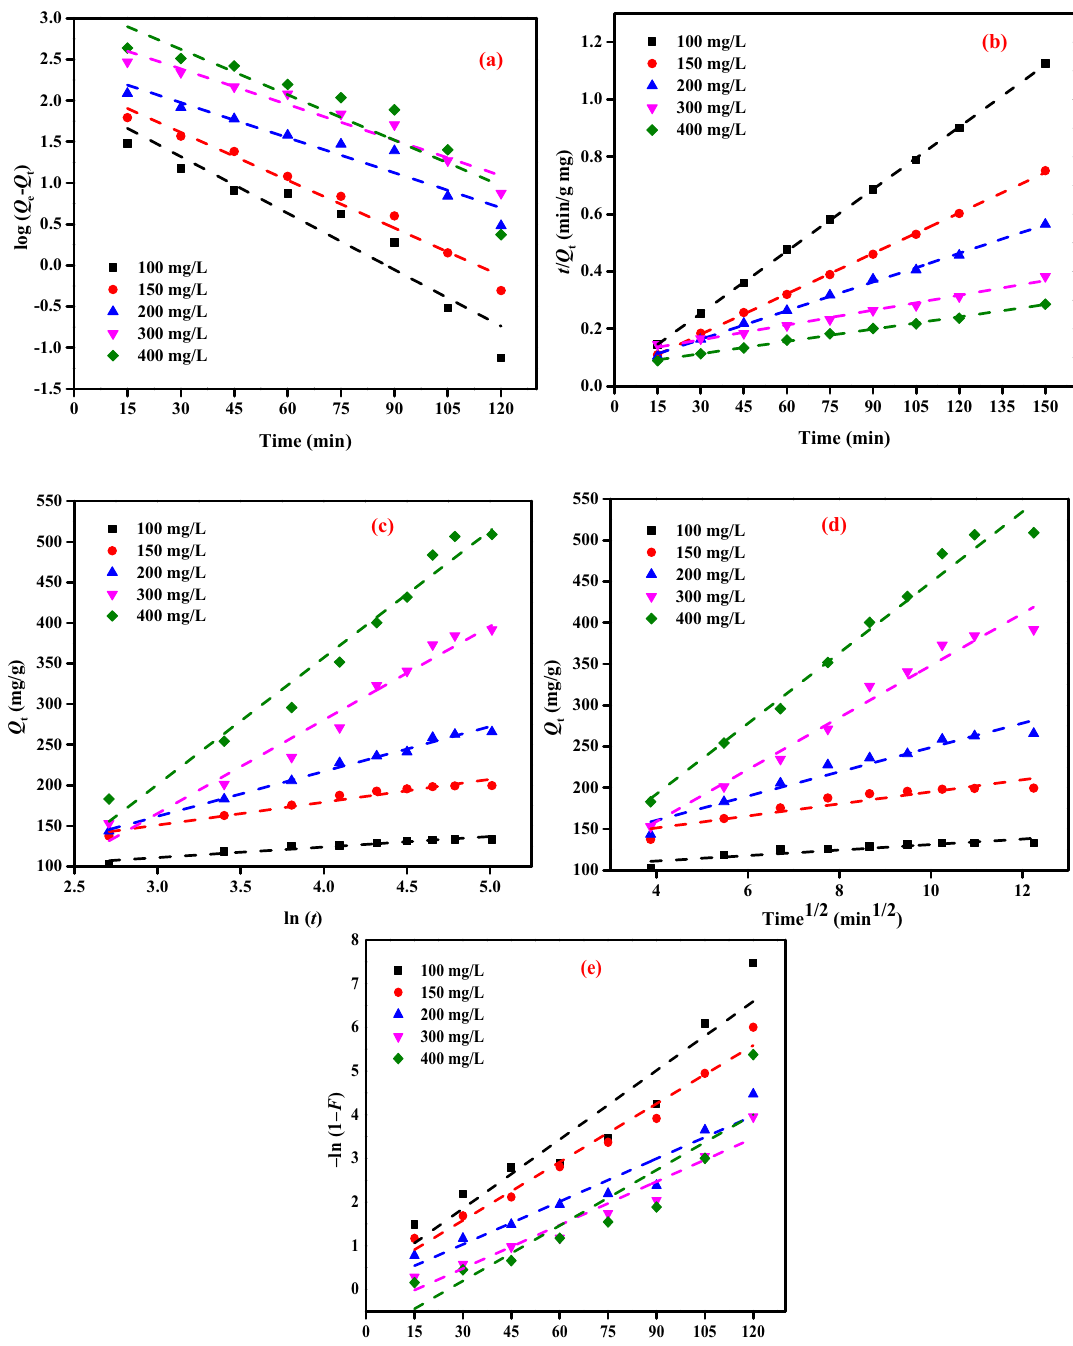
Figure 11. ( a ) PFOM, ( b ) PSOM, ( c ) EM, ( d ) IPDM, ( e ) FDM of AY11 dye removal by PPAC adsorbent (beginning concentration (100–400 mg/L), PPAC dose (0.75 g/L), Temp. (25